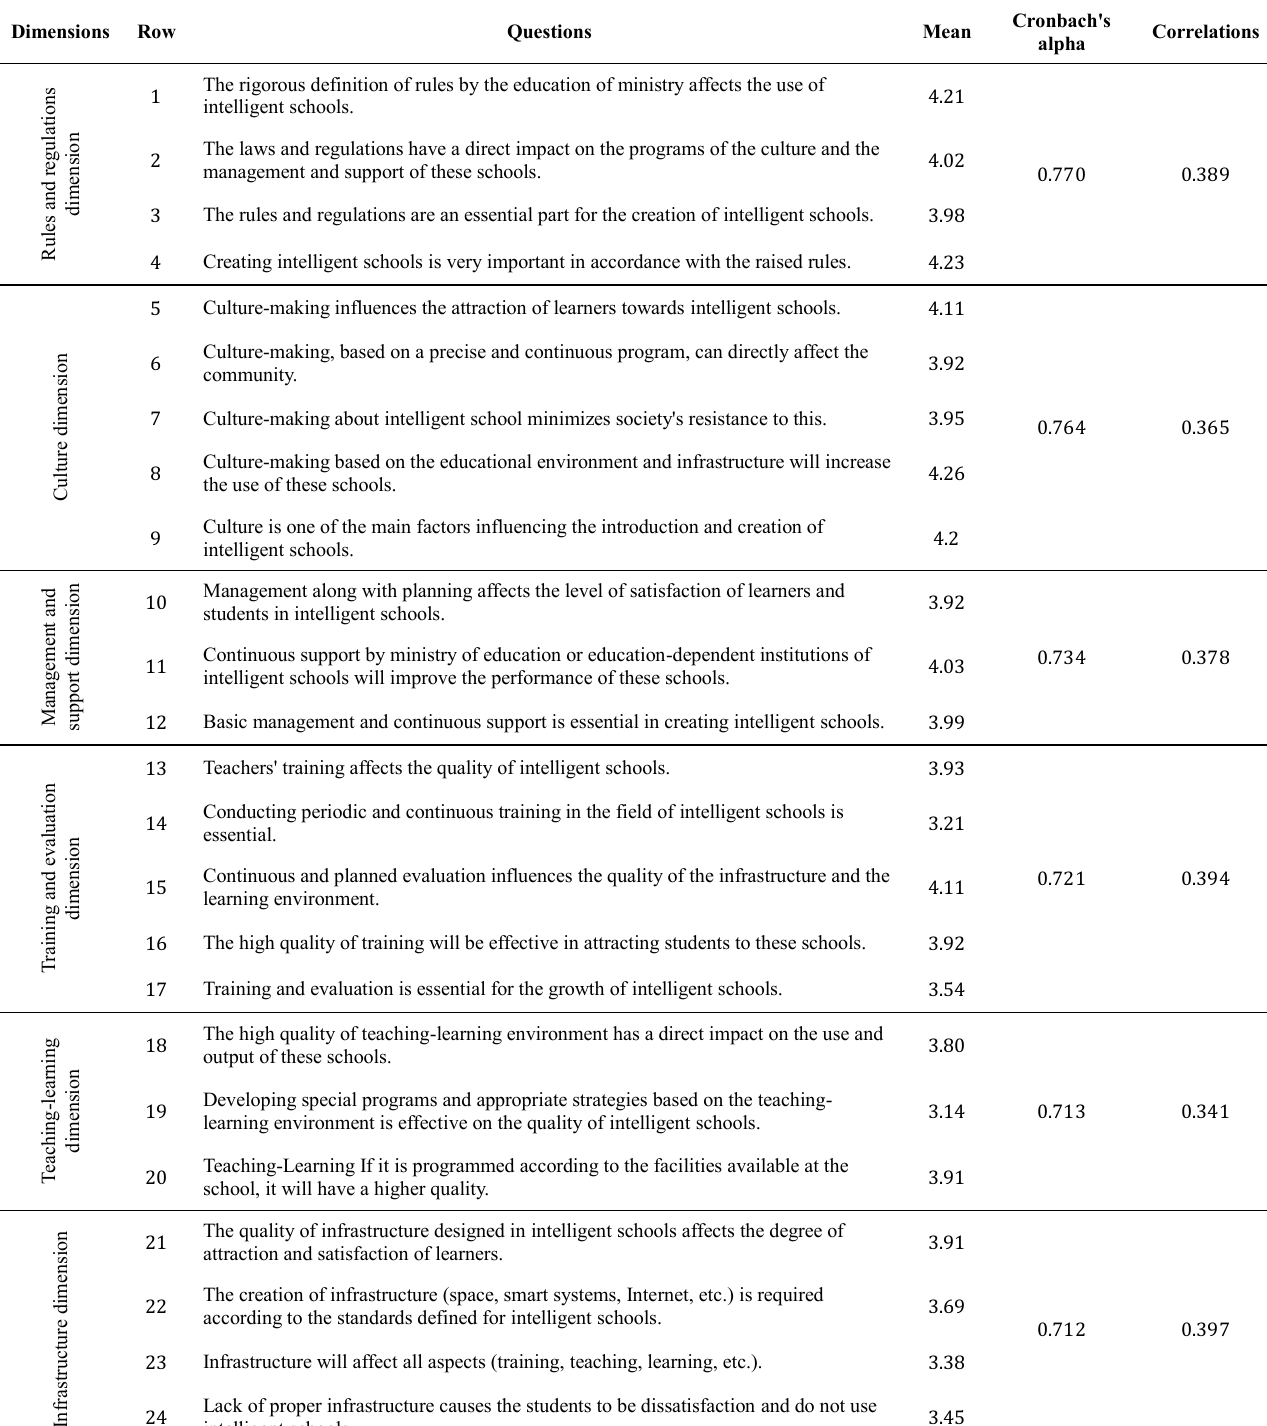
Table 3. Mean, Cronbach's alpha and correlations of